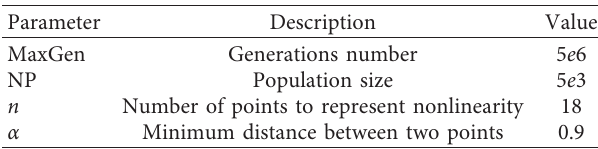
Table 4: Summary of WH-EA parameter settings for numerical